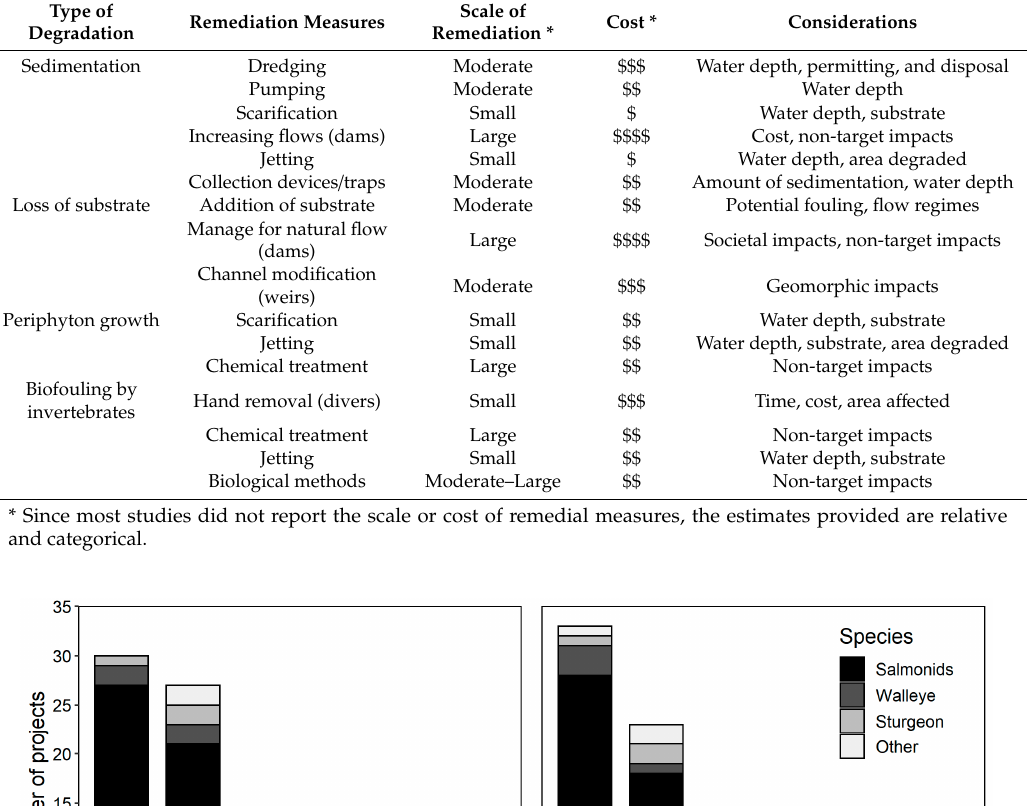
Table 2. Types of rocky spawning habitat degradation, remediation measures, potential scale (small to large) of remediation measures, cost (low to high), and considerations for remediation.